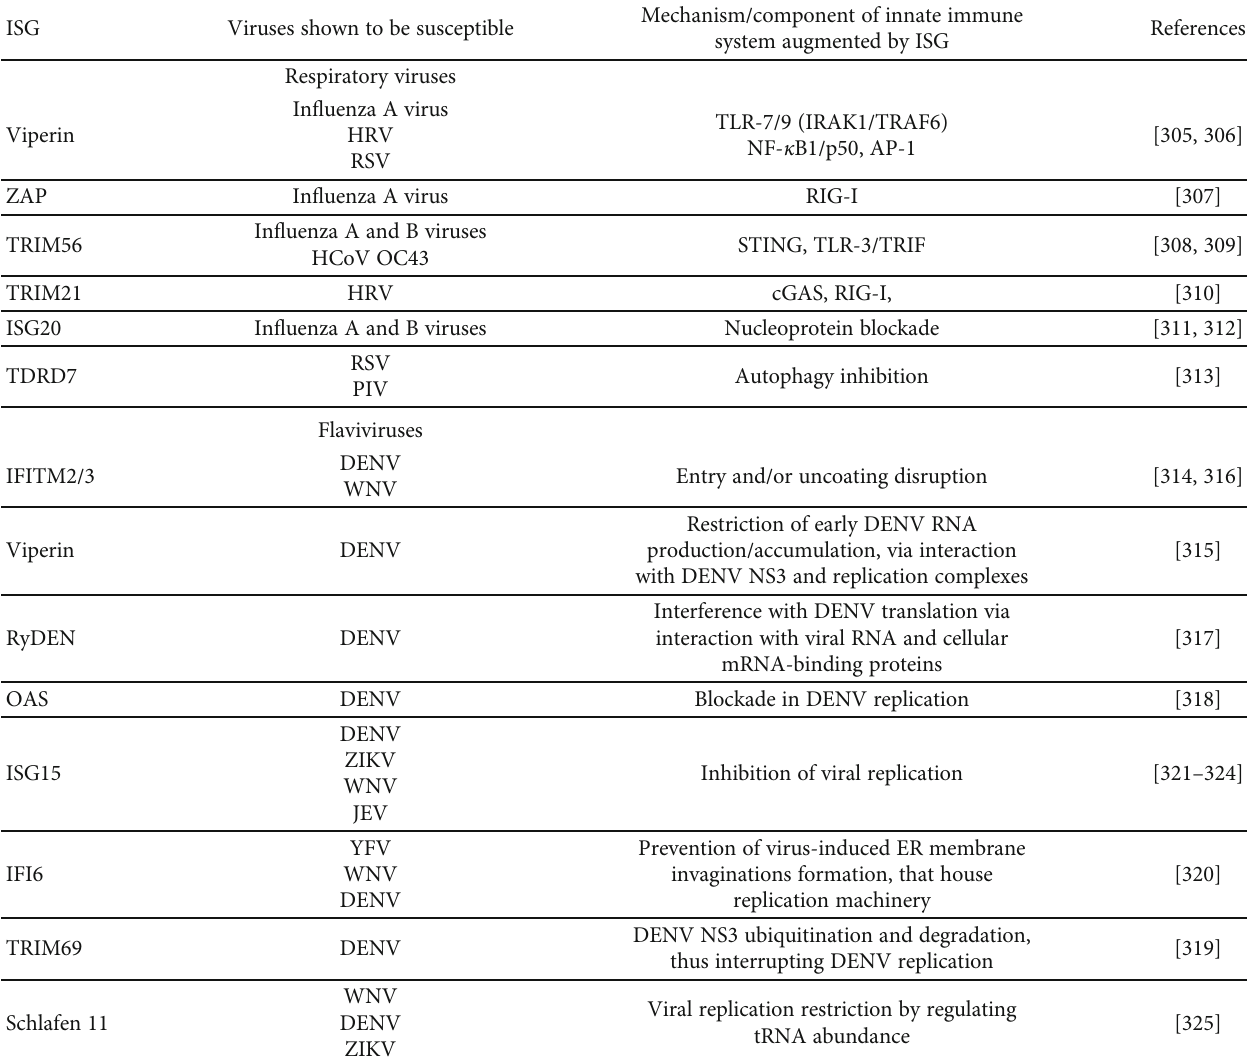
Table 2: Some interferon-stimulated genes that inhibit respiratory virus and fl avivirus